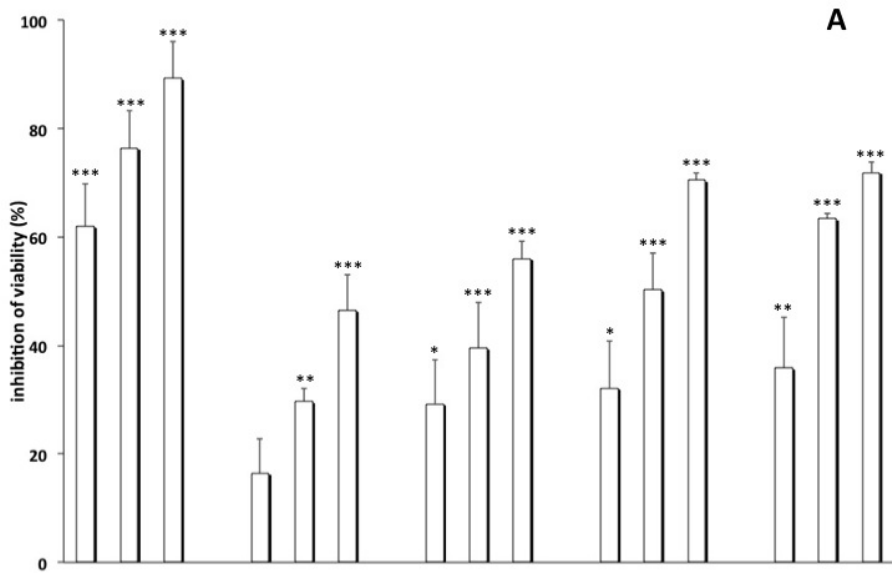
Figure 3. Effect of 8a , 8b , 10a and 10b on cell viability and proliferation. A549 cells were incubated with cisplatin, 8a , 8b , 10a and 10b (50, 100 and 200 µM) for 72 h. Thereafter, cell viability (panel A ) and proliferation (panel B ) were determined, respectively, by MTT and BrdU assay as described in the Experimental Section (*** p < 0.001, ** p < 0.01, * p < 0.05 vs. untreated